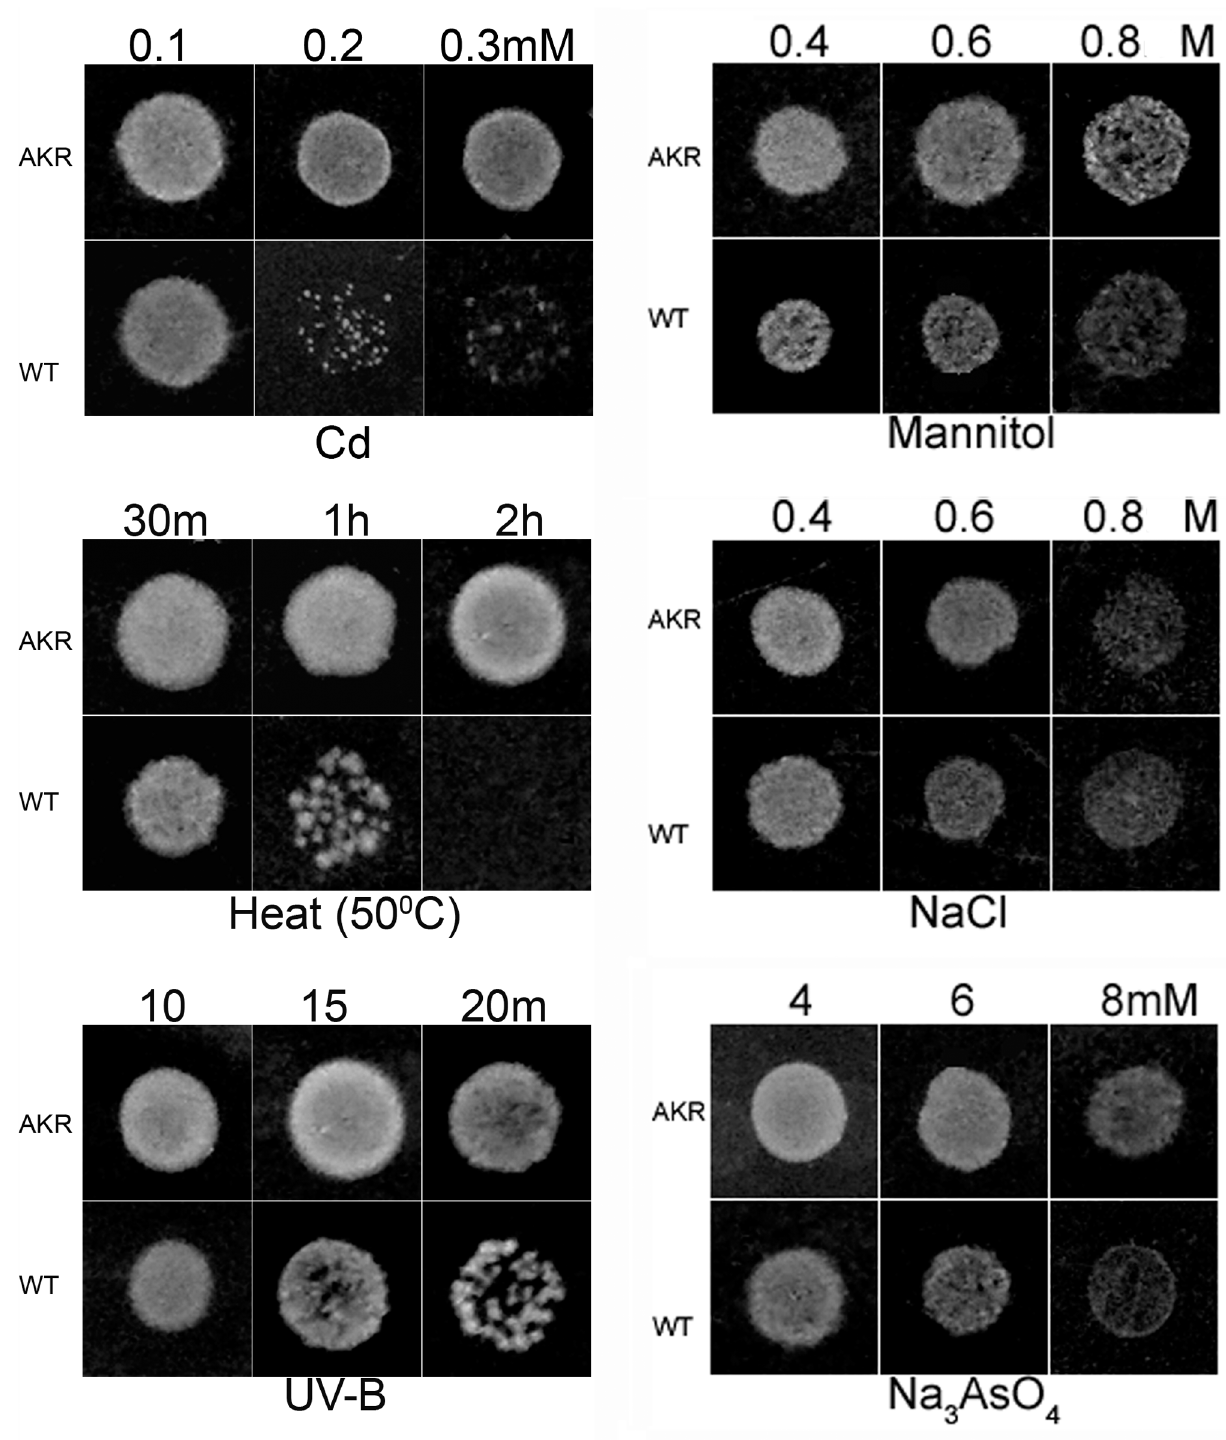
Fig 4. Spot assay of E . coli strain BL21 (DE3) transformed with vector alone (BL/pET21a) and recombinant plasmid (BL/ pET21a-AKR) under different abiotic stresses. 3 μ L of sequential dilutions (only growth at dilution level 10 − 2 is shown here) were spotted on the Luria Bertani (LB) plates supplemented with varying concentration of (a) cadmium, (b) mannitol, (c) arsenic and (d) NaCl. For (e) UV-B and (f) heat (50°C),cells were pretreated for different time intervals and then spotted on the LB plates. All spot tests were performed in triplicate.